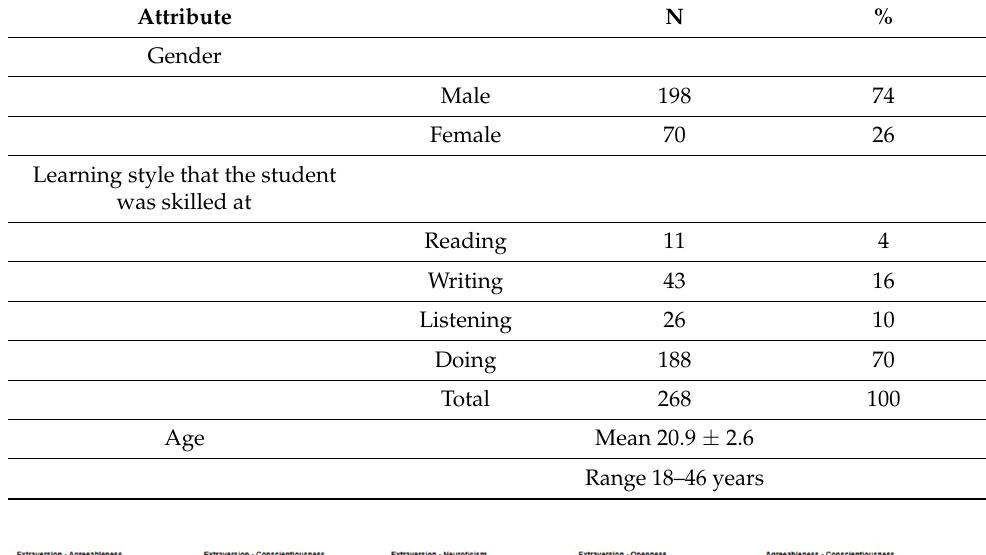
Table 1. Distribution of the attributes of interest.